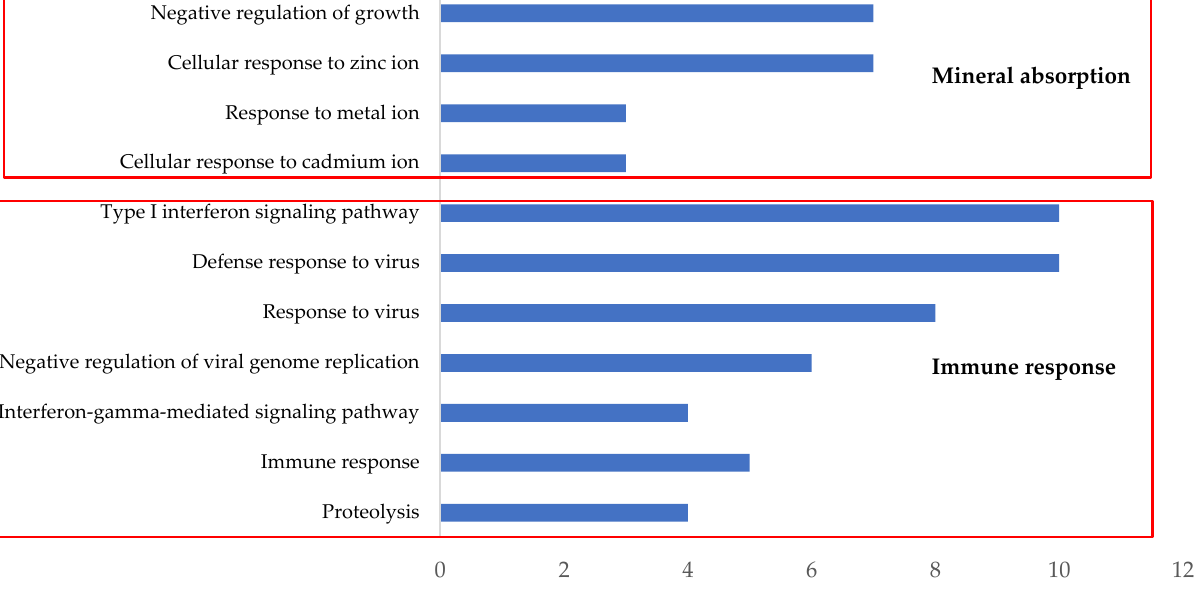
Figure 8. Enriched Gene Ontology Biological Processes (GO BPs) modified in Saos-2 cells exposed to rough surfaces (Ra = 1 µm) of Y-TZP discs for 96 h (determined through DAVID Bioinformatics Resources v6.8). (Z score > 1.3).